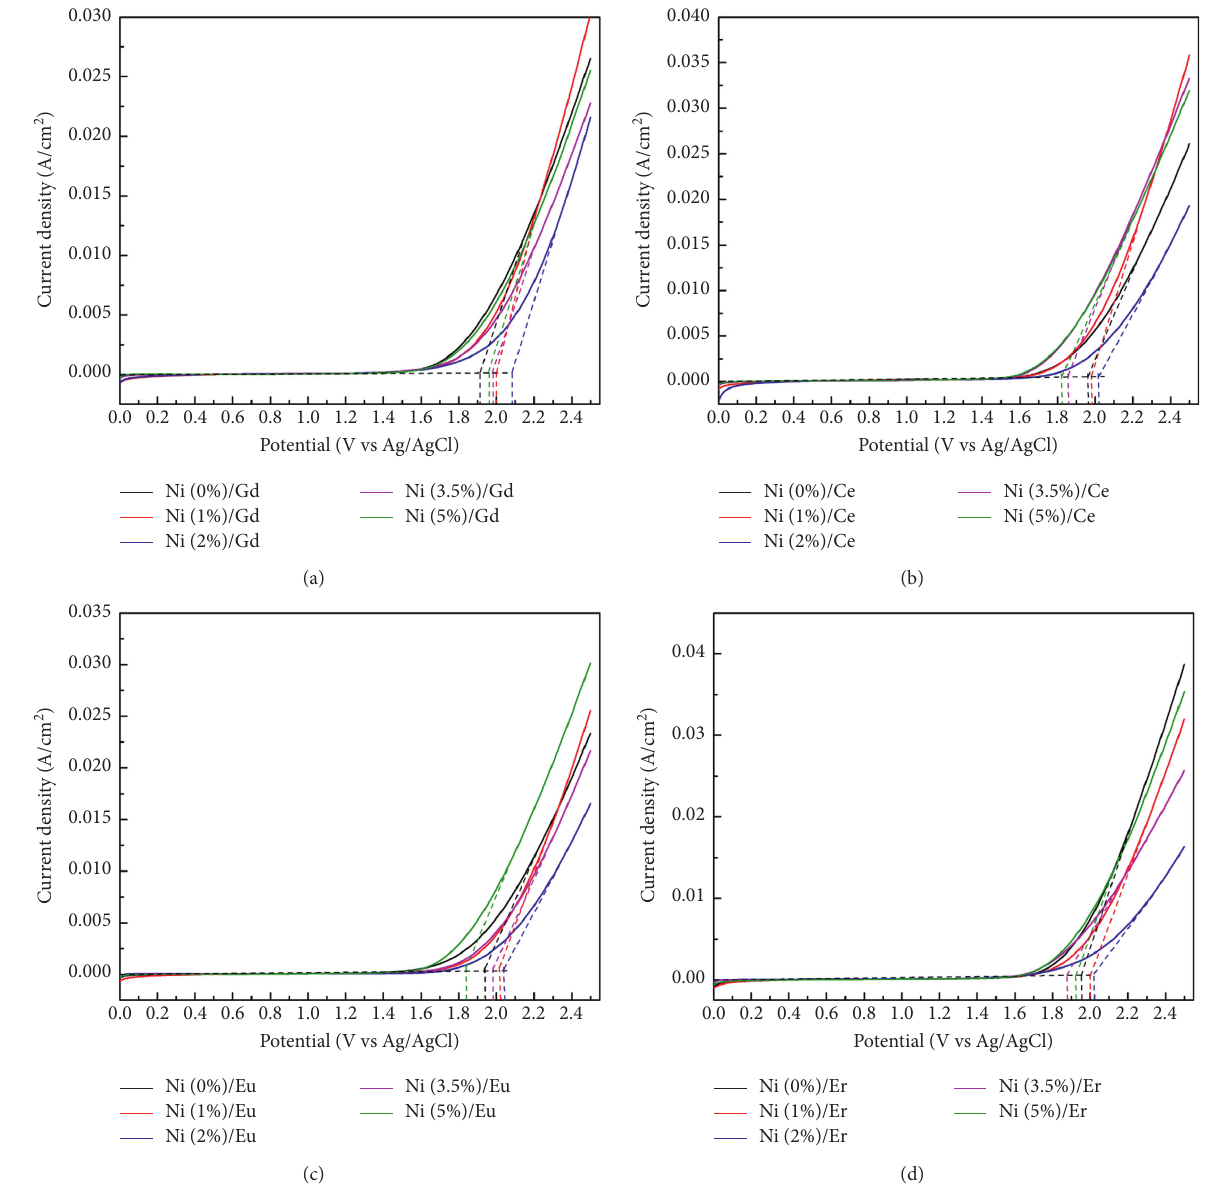
Figure 6: Linear voltammetric curves of Ti/SnO (Re � (a) Gd, (b) Ce, (c) Eu, and (d)